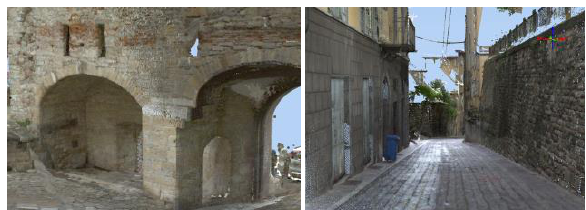
Figure 6. Two views of the point cloud acquired with the MMS in the historic city centre of Bergamo “Città Alta”. The data acquisition lasted ca 3 hours to cover some 9 km of roads in the historic city part (Figure 5, right). Data post-